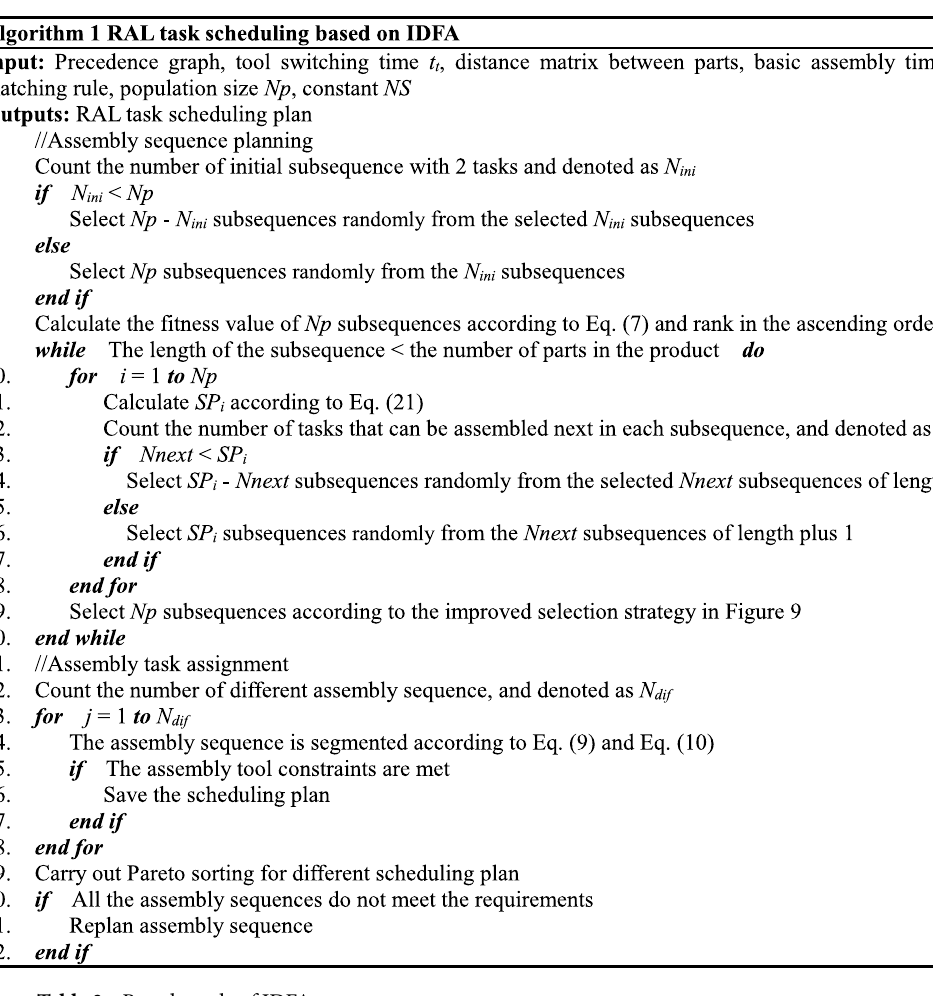
Table 3. Pseudo code of